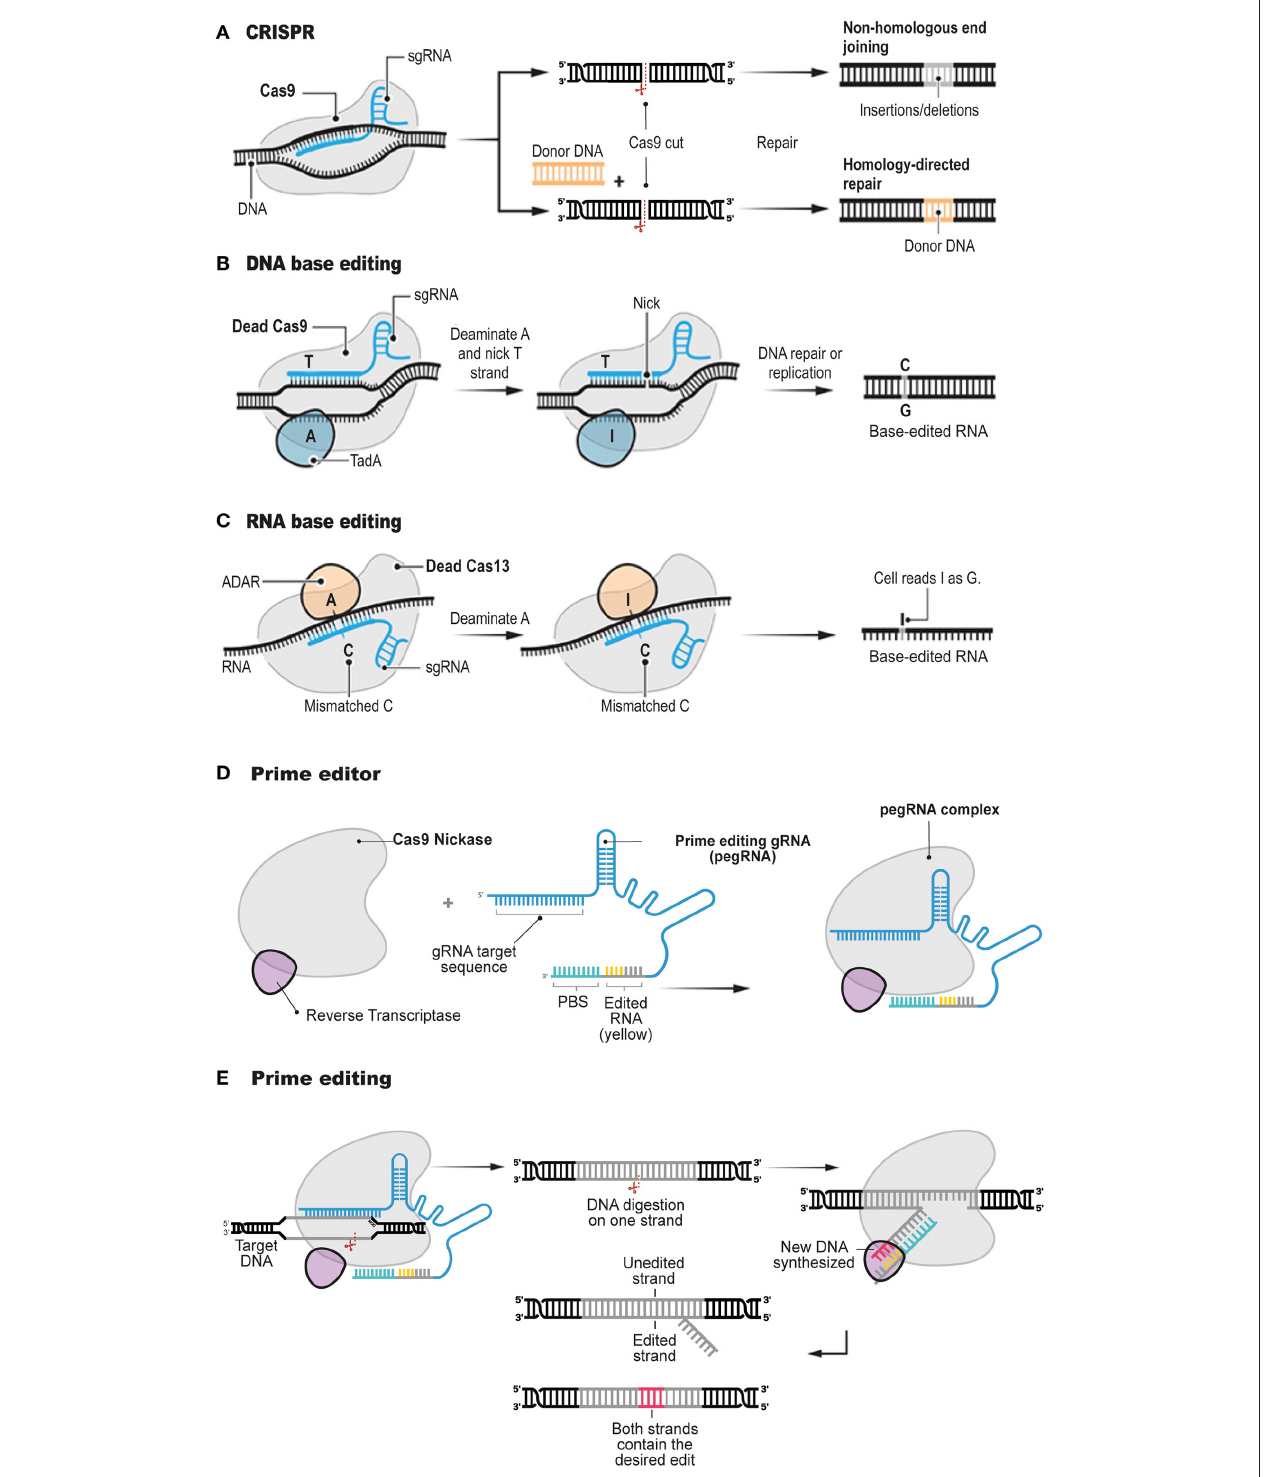
FIGURE 1 | Structure and function of prime editor. The conventional CRISPR DNA editor (A) . CRISPR relies on the ability of CRISPR gRNAs to target the Cas9 endonuclease to precise genomic locations, where Cas9 introduces DSBs. Base editors do not digest the double strand, but instead they chemically alter single bases with deaminase enzymes such as TadA ( B , DNA base editor) and ADAR ( C , RNA base editor). Prime editor (D) involves a longer-than-usual gRNA, known as pegRNA, and a fusion protein consisting of Cas9 H840A nickase fused to a modified RT enzyme. The Cas9 element of the prime editor digest the genomic DNA and the RT element polymerises DNA onto the nicked strand based on the pegRNA sequence (E) . Adapted from Anzalone et al. (2019) and Matsoukas (2018a).